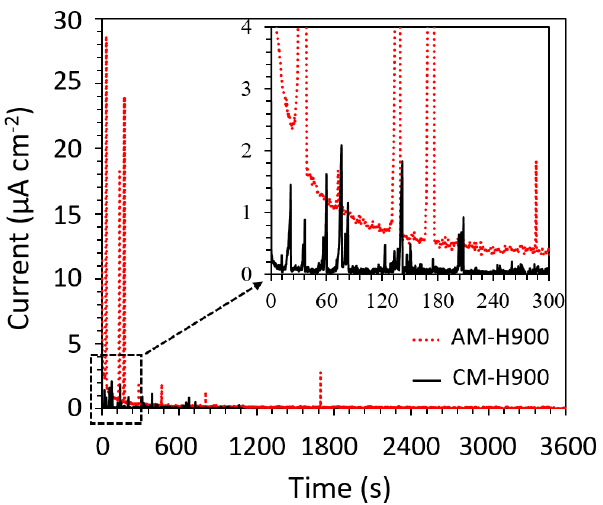
Figure 4. Current transients recorded during chronoamperometry tests performed in 0.5 M NaCl solution for the AM and CM samples at a fixed potential of +250 mV versus E corr .